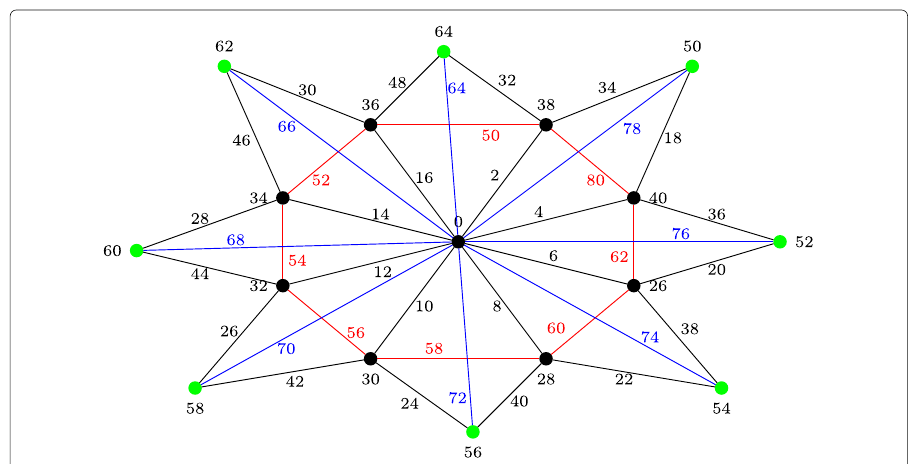
Fig. 5 An edge even graceful labeling of the graph K 1 + sf 8